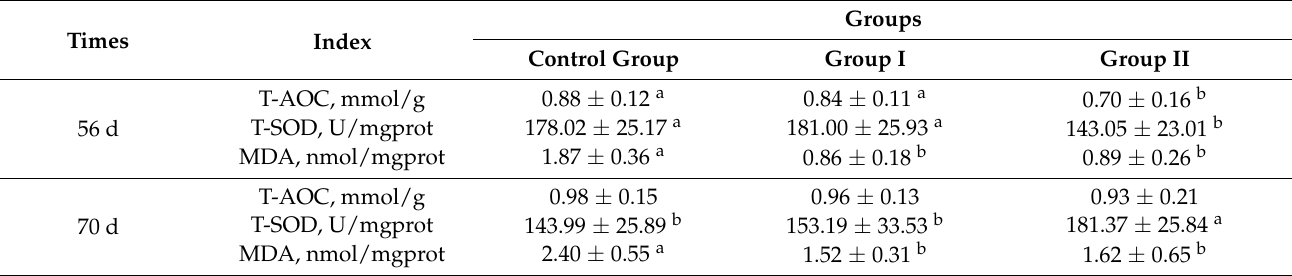
Table 8. Effects of feed restriction and compensation on antioxidant capacity in jejunum of